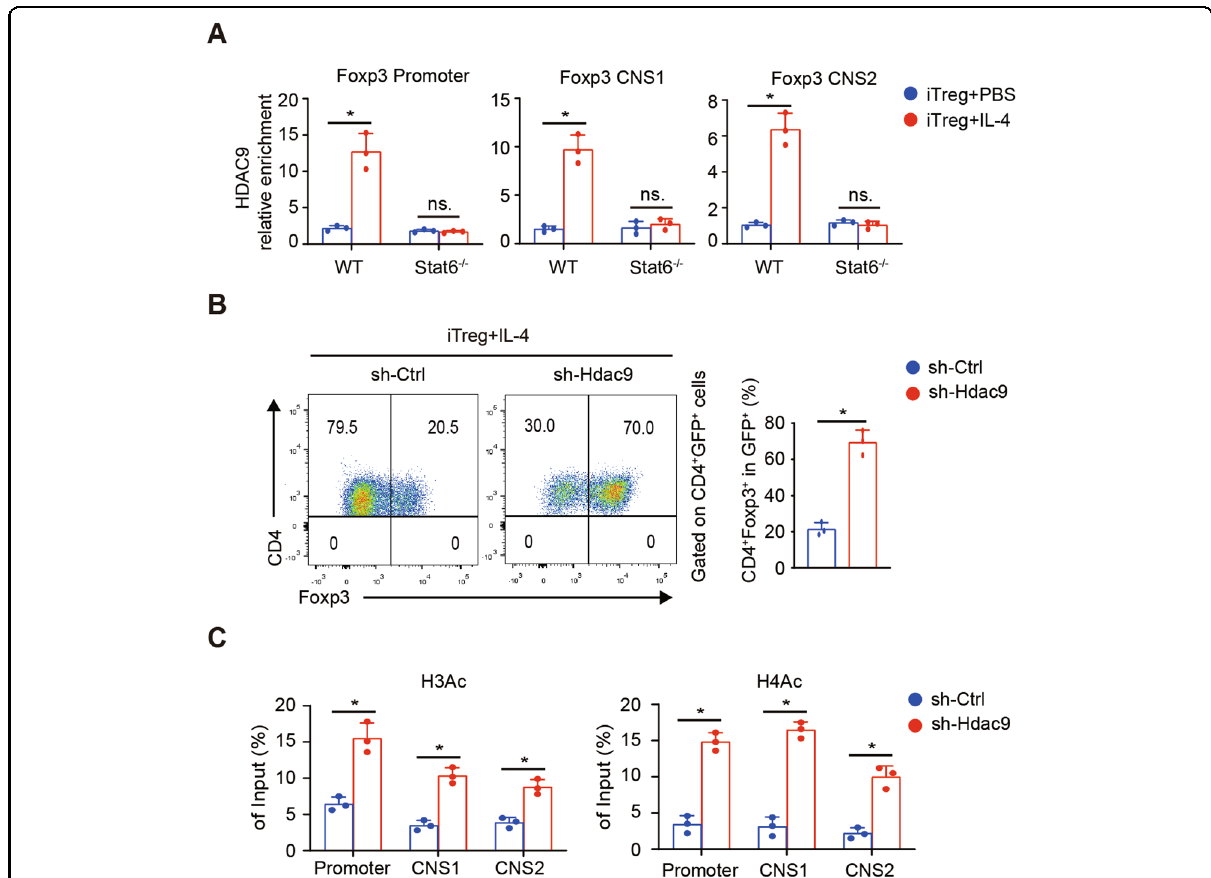
Fig. 5 Hdac9 knockdown abrogates the Foxp3 suppression of IL-4. A ChIP-qPCR assays for HDAC9 enrichment in the Foxp3 promoter, CNS1 and CNS2 regions. B CD4 + T cells were transfected with a retrovirus carrying Hdac9-speci fi c or Ctrl shRNA and cultured under iTreg-polarizing conditions with IL-4. On day 3, FCM assay was used to measure the percentages of Foxp3 + cells among retrovirus-transfected CD4 + T cells (GFP + ). C ChIP-qPCR assays for H3Ac and H4Ac modi fi cations in the Foxp3 promoter, CNS1 and CNS2 regions were performed with retrovirus-transfected CD4 + T cells on day 2. Data are the mean ± SD and representative of three independent experiments. * p <